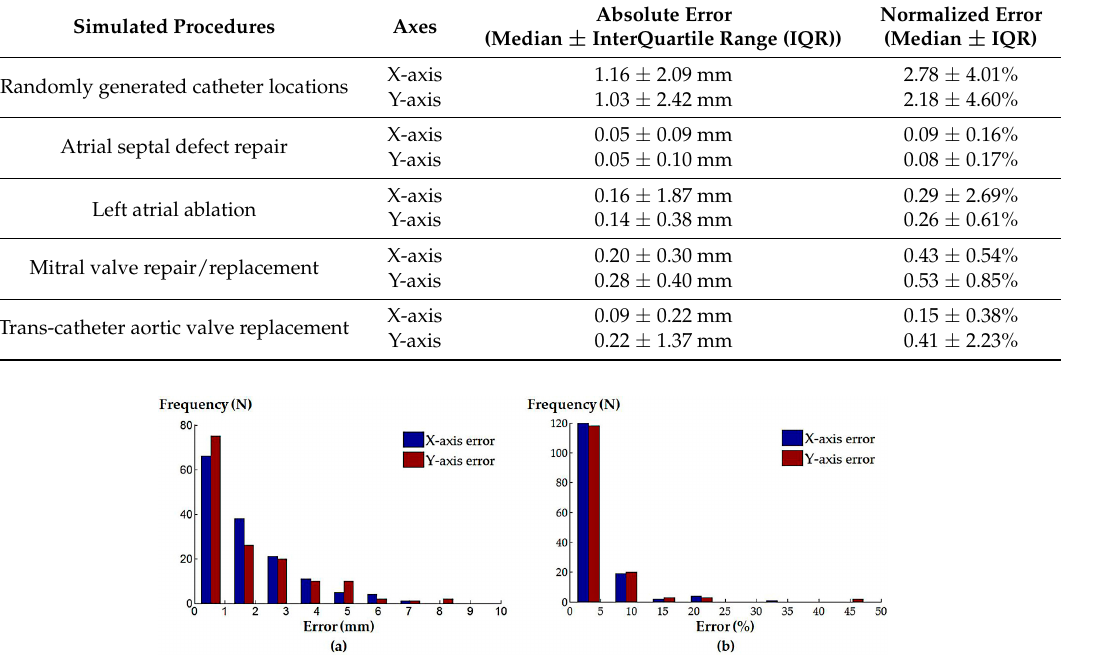
Figure 8. Histograms of the ( a ) absolute positioning errors and ( b ) normalized positioning errors for the randomly generated catheter tip positions.